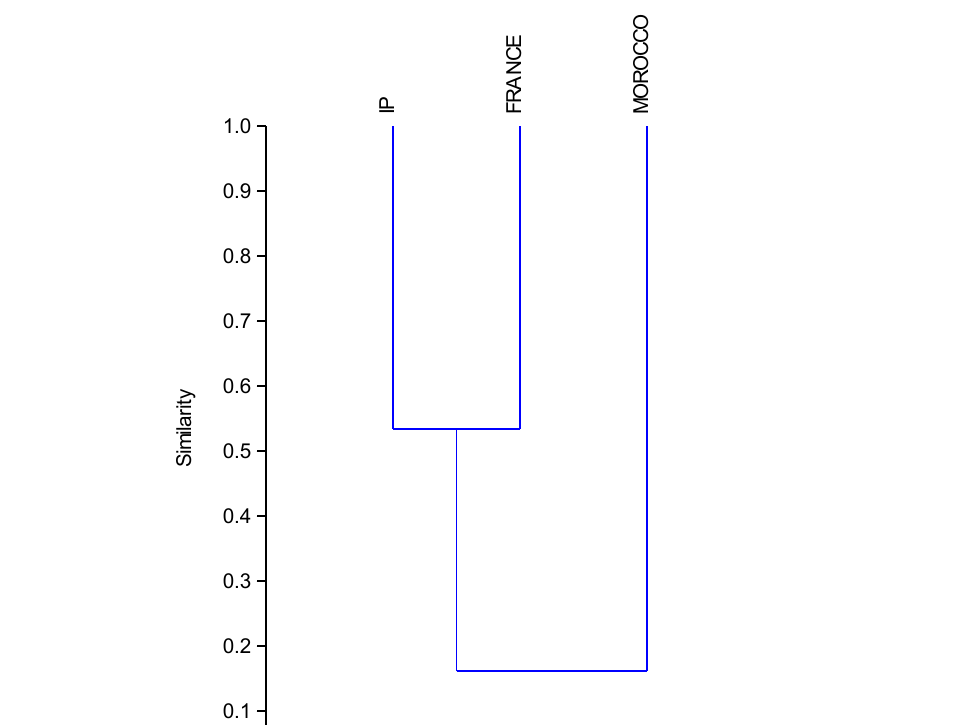
Figure 4. Cluster analysis based on the similarity (Jaccard’s Index) of the ant species found in the three adjacent areas (IP, France and Morocco).